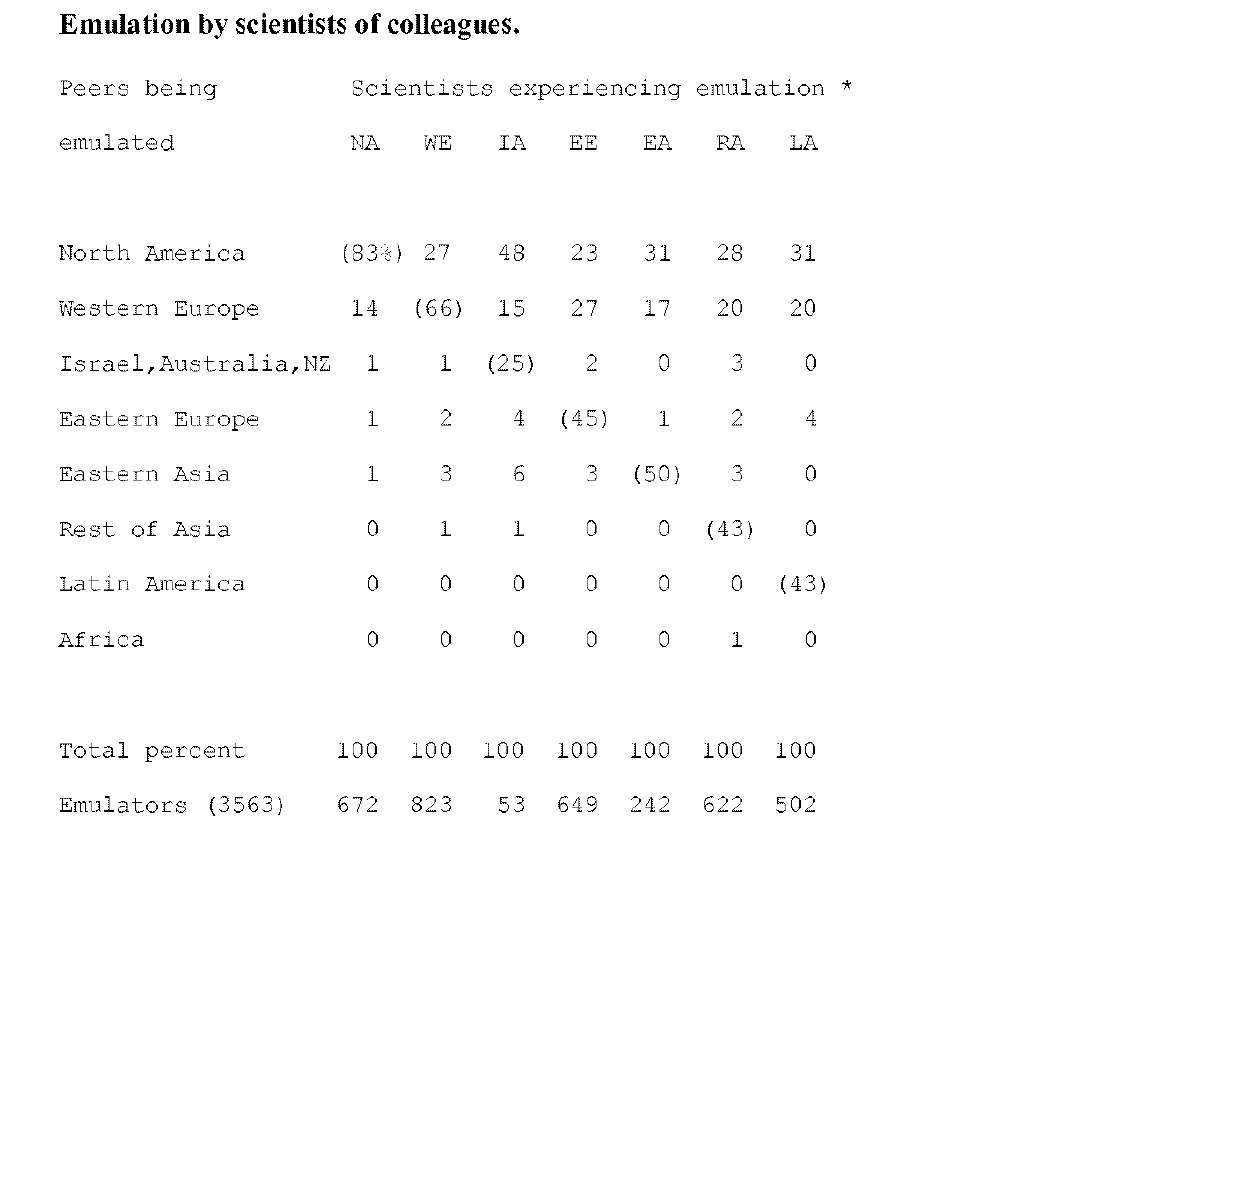
Emulation by scientists of